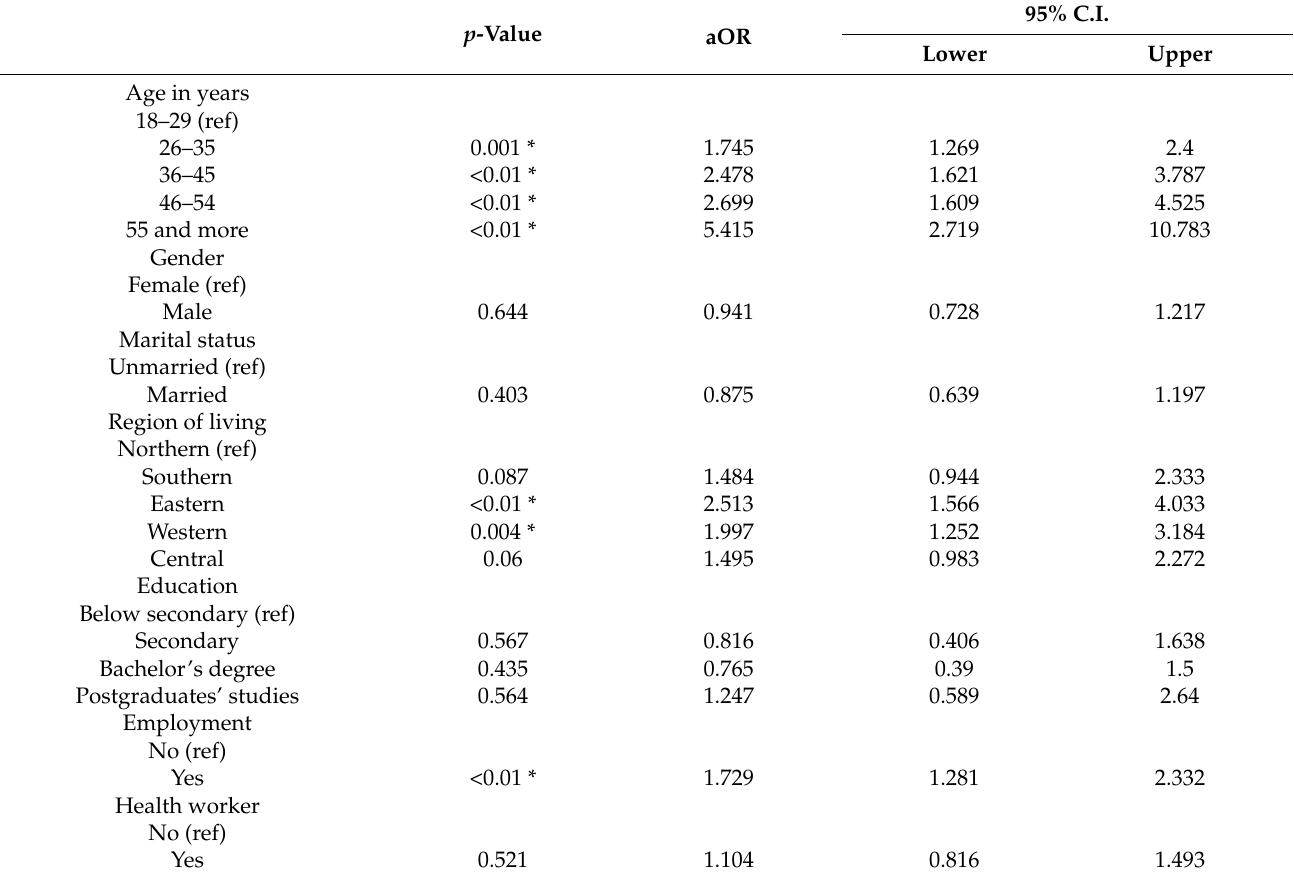
Table 5. Multiple logistic regression analysis for estimates of predictors associated with getting COVID-19 vaccine booster